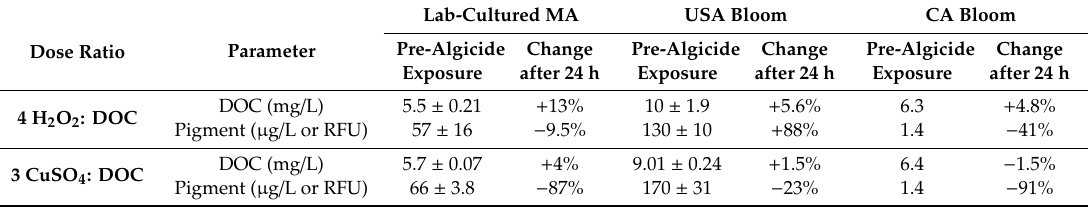
Pigment ( µ g / L or RFU) 66 ±